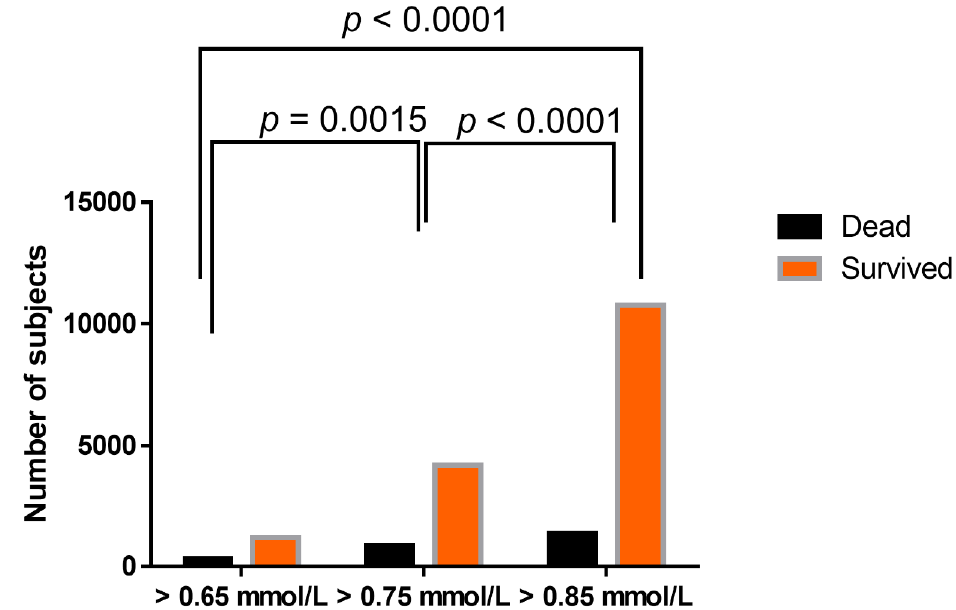
Figure 4. Differences in in-hospital mortality ratio between hypomagnesemic groups in dependence on lower reference value applied. Analysis was performed using Chi-square test, p < 0.0001.